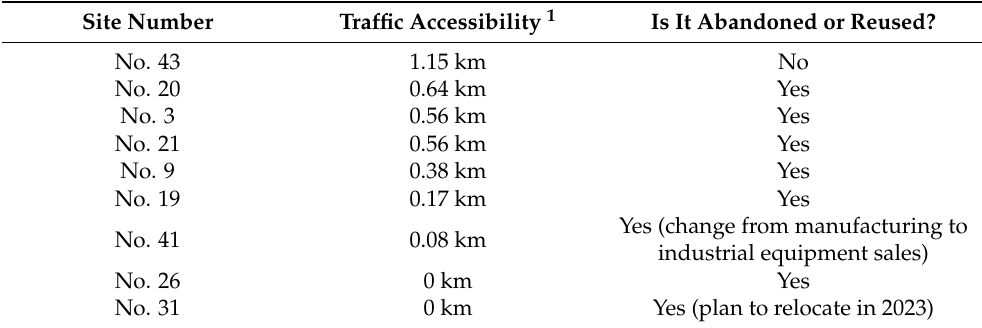
Table 1. Statistics of accessibility analysis of labor-intensive industrial heritage.